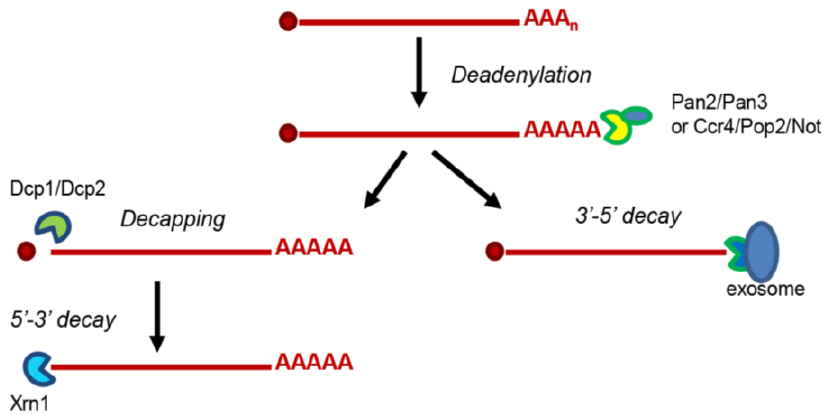
Figure 1. The two main mRNA decay pathways in the cytoplasm: The deadenylation-dependent 5′-3′ decay pathway and the exonucleolytic 3′-5′ decay pathway. Pan2/Pan3: PAB-dependent poly(A)-specific ribonuclease subunits; Pop: PGK promoter directed OverProduction; Not: Negative regulator of transcription subunit; Ccr4: C-C motif chemokine receptor 4; Dcp1/Dcp2: mRNA-decapping enzyme subunit 1/2; Xrn1: 5'-3' exoribonuclease 1